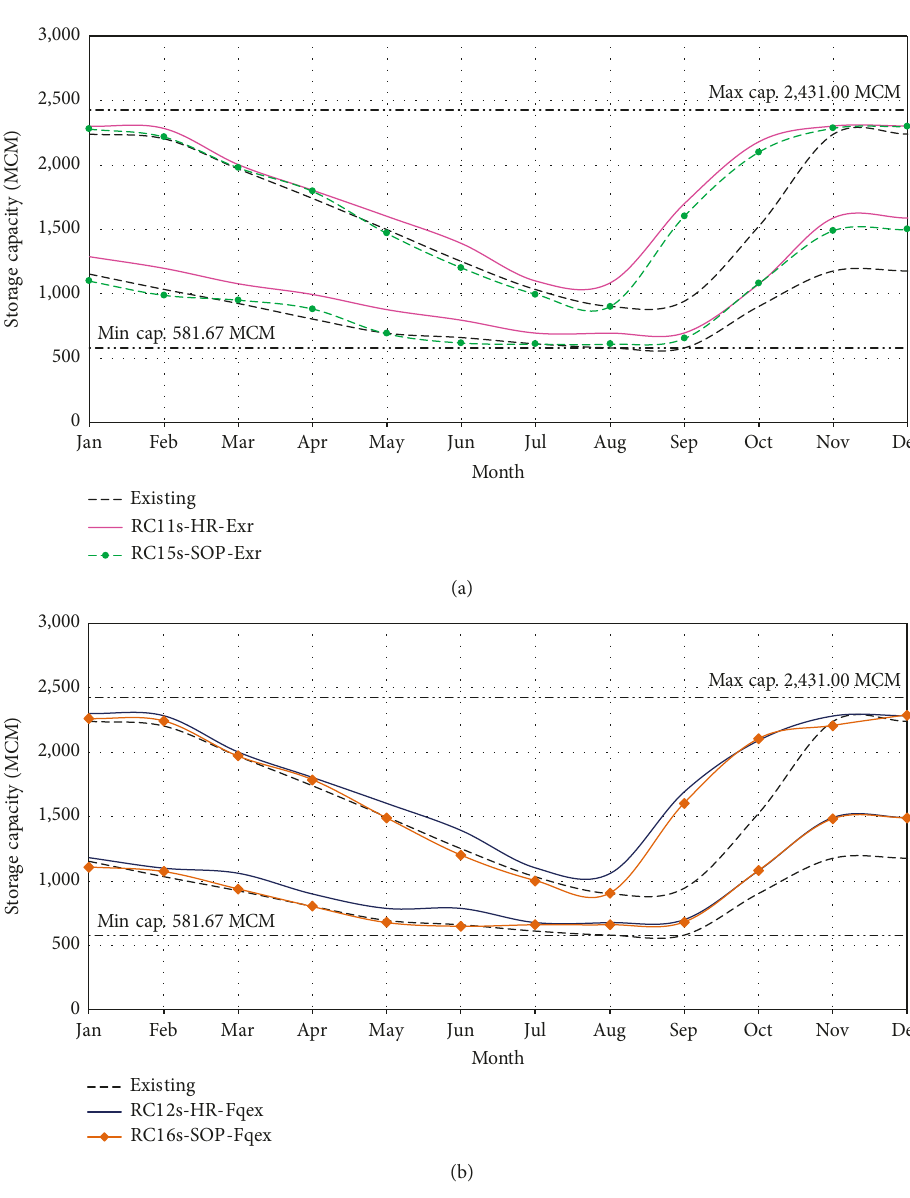
Figure 10: Optimal rule curves of the Ubolratana reservoir considering sedimentation with objective functions of (a) the minimal average excess water per year and (b) the minimal frequency of excess